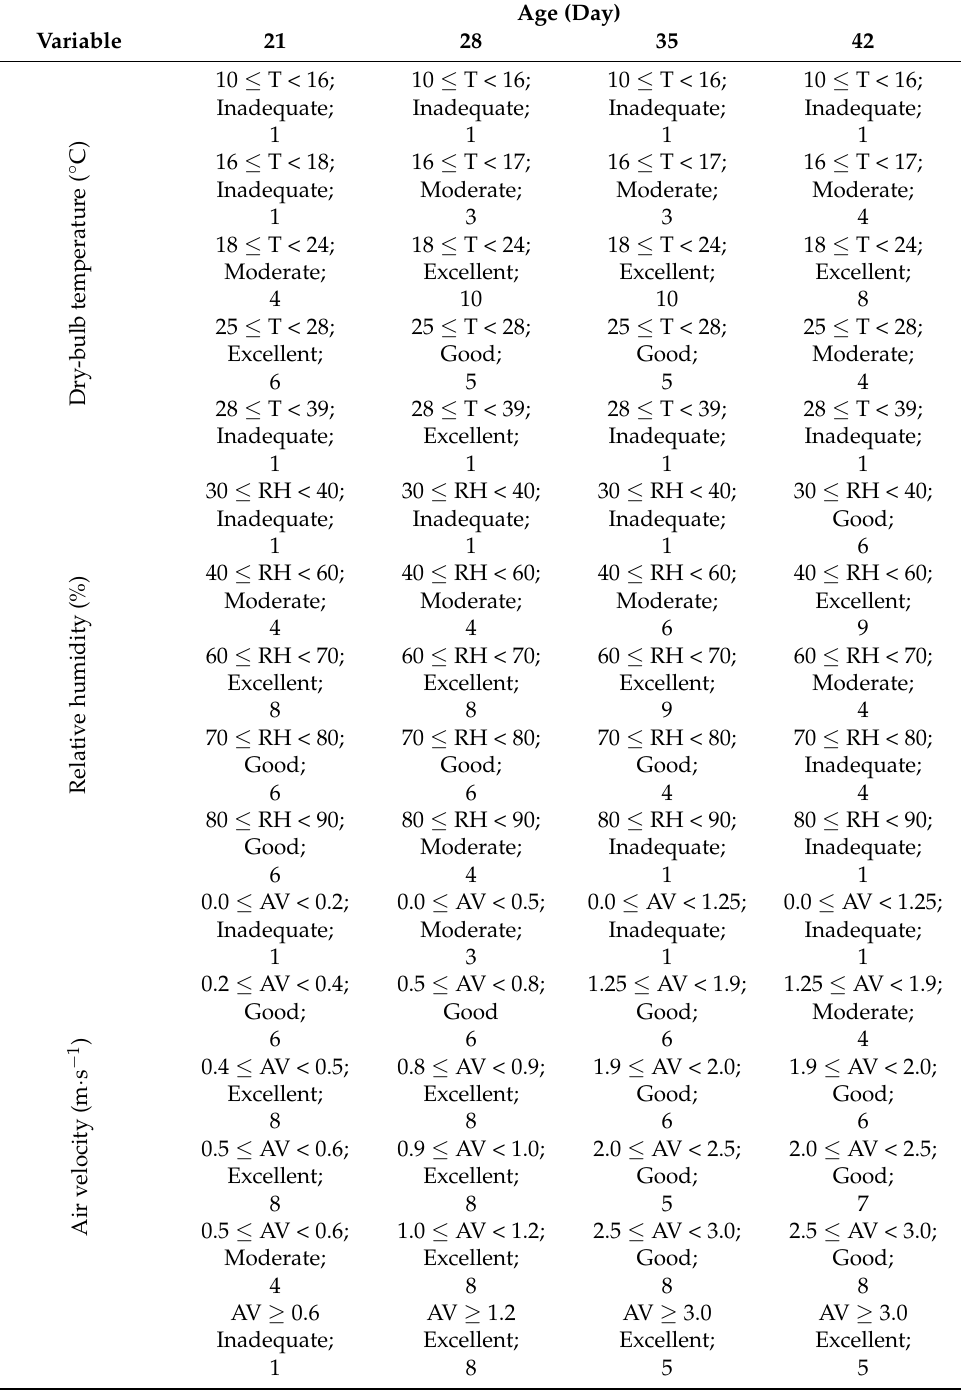
Table 2. The range of the environmental variables discretized as a function of broilers’ age, the estimated RC, and the weight the rearing condition infers in the final